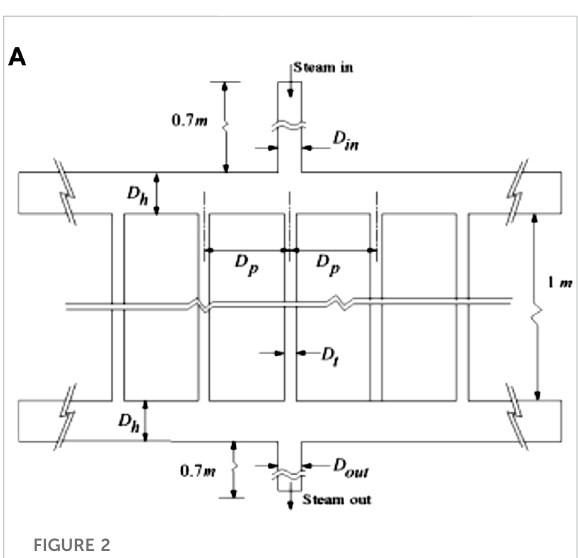
FIGURE 2 Schematic of con fi guration (A) as considered by Gandhi et al.